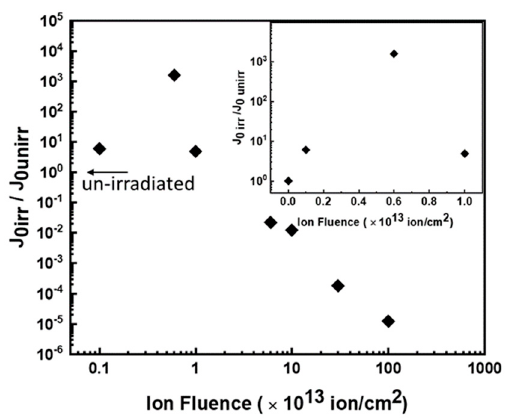
Figure 5. Pre-exponential factor J 0 of irradiated devices normalized to the value before irradiation as a function of ion fluence, as obtained from the fit of I–V characteristics. In the inset, the values at low fluences are shown in detail.